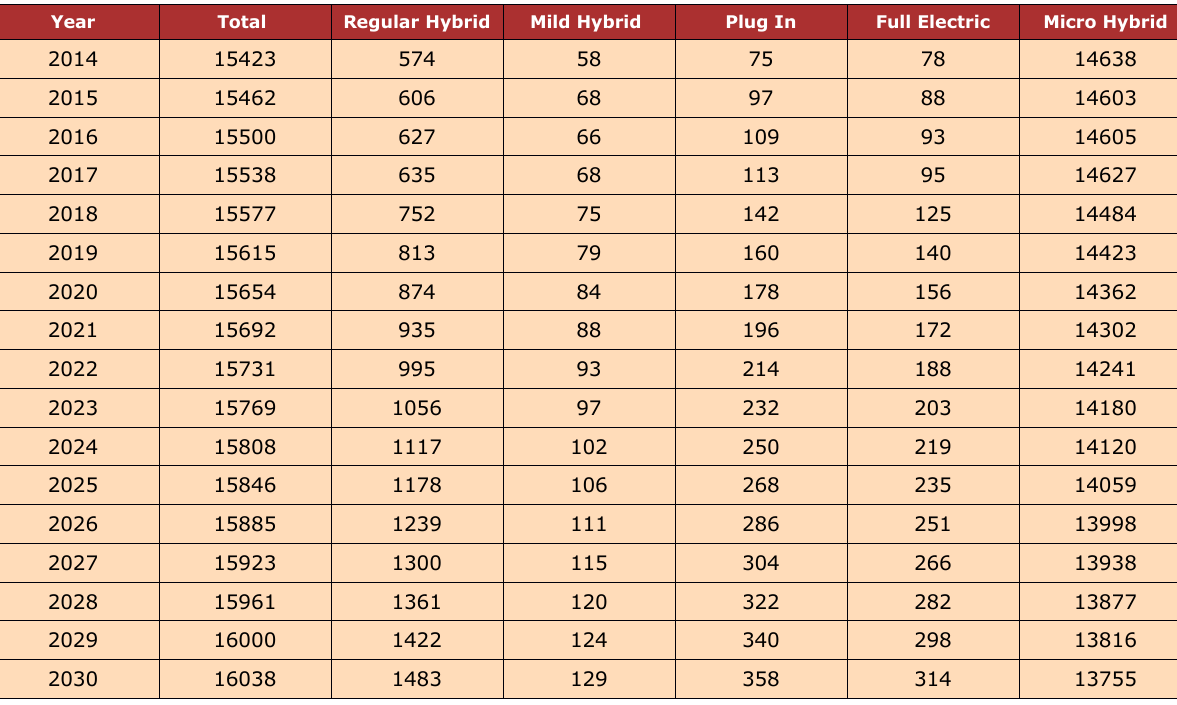
Table 4. Count of Electrified Vehicles by Type (In